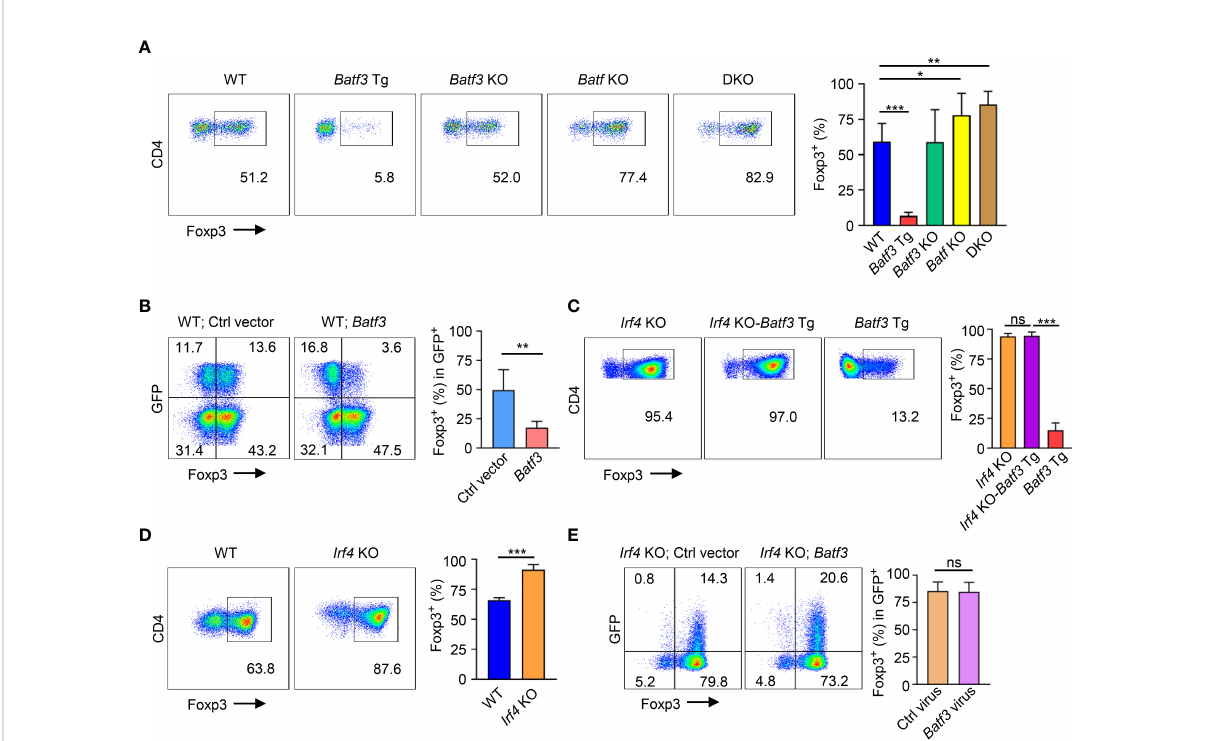
FIGURE 1 BATF3 and IRF4 on FOXP3 expression (A, C, D) Naïve CD4+ T cells were cultured for 72 hours in iTreg-inducing conditions. % FOXP3 shown as percentage of live CD4+ cells that are FOXP3+. n = 3. Data displayed as mean + S.D. (B, E) WT or Irf4 KO naïve CD4+ T cells were